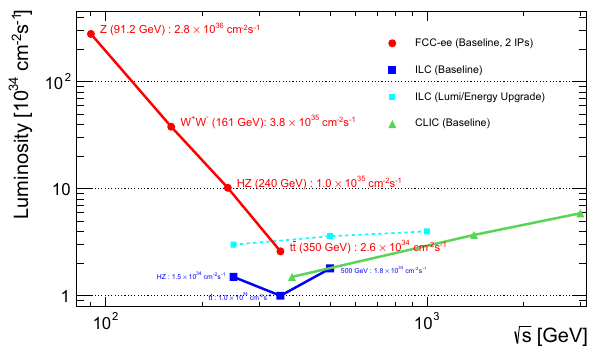
Fig. 1 Comparison of e + e − collider luminosities